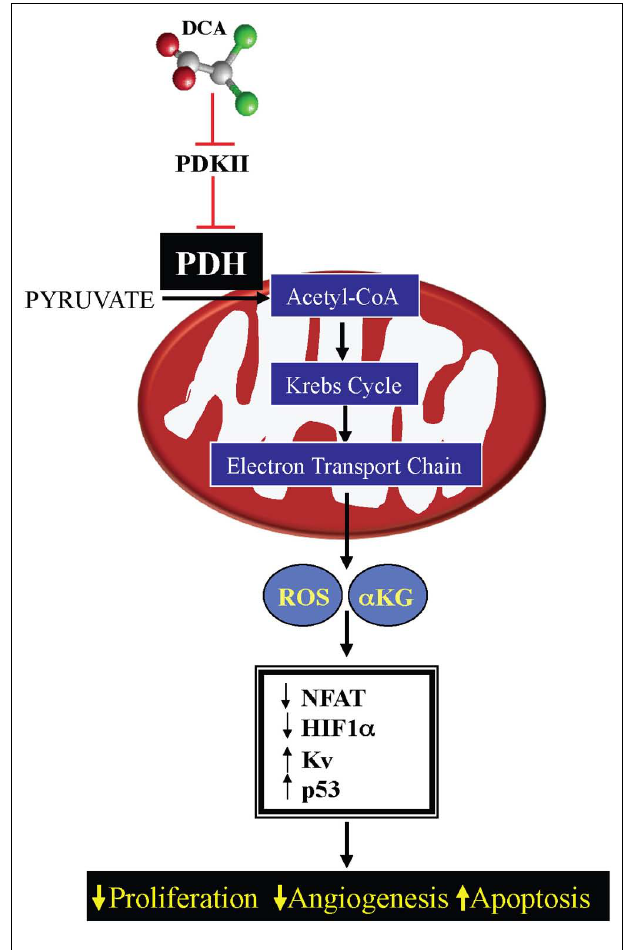
FIGURE 3 | Mechanism of DCA in cancer: DCA inhibits pyruvate dehydrogenase kinase (PDK) resulting in activation of pyruvate dehydrogensae (PDH). By increasing mitochondrial-based GO and acetyl-CoA levels, DCA increases Krebs’ cycle and electron transport chain activity, increasing mitochondrial-derived reactive oxygen species (mROS) and α -ketoglutarate ( α KG) levels.This results in decreased activation of pro-proliferative transcription factors, like NFAT and HIF1 α and increasing the activity of Kv channels and the tumor suppressor protein p53.